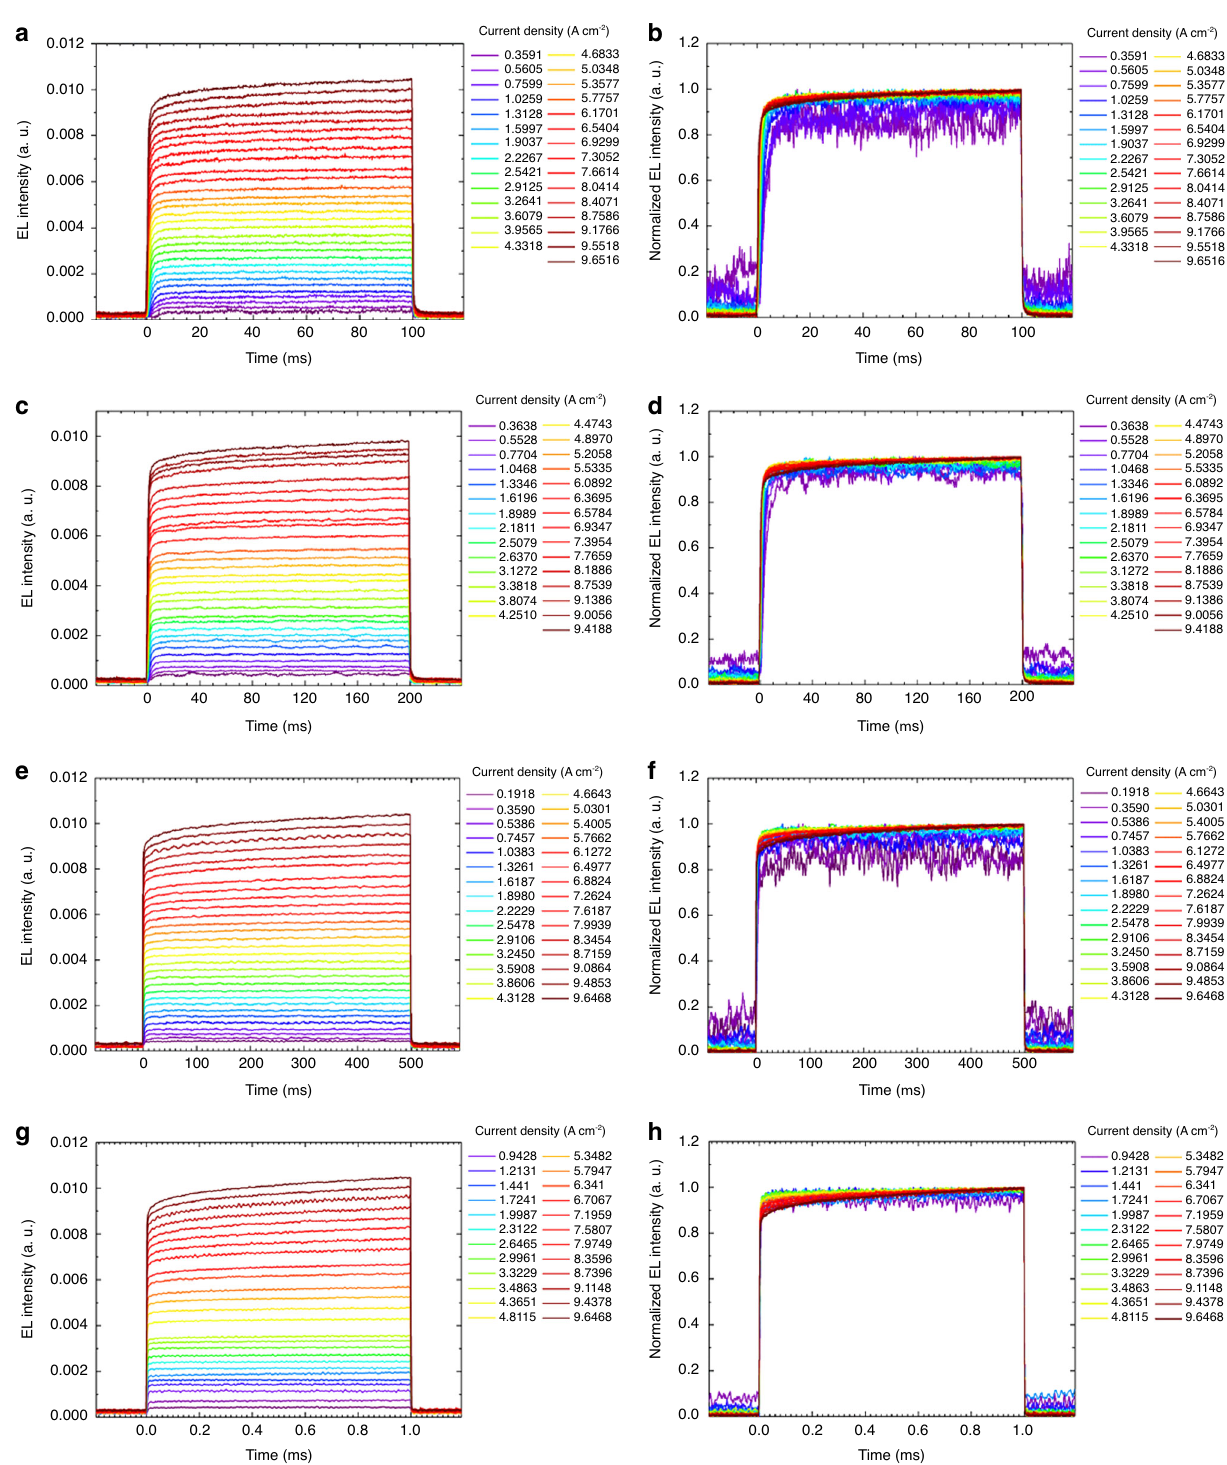
Fig. 6 Transient EL responses of OLED device C at long pulses. Temporal pro fi les of EL intensity when the pulse widths were a , b 100 µ s, c , d 200 µ s, e , f 500 µ s, and g , h 1 ms. For ( b , d , f , and h ), the EL intensities were normalized to make it easy to see the response shapes. The EL intensity from OLEDs were recorded using a photomultiplier tube (PMT) (C9525-02, Hamamatsu Photonics) for the measurement of temporal emission pro fi until the very high current density of 10 A cm − 2 . The suppressed STA and suppressed ef fi ciency rolloff for DCNP:BSBCz-based OLED devices showed an interesting material combination and device architecture for the fabrication of prospect OSLDs with high performance.